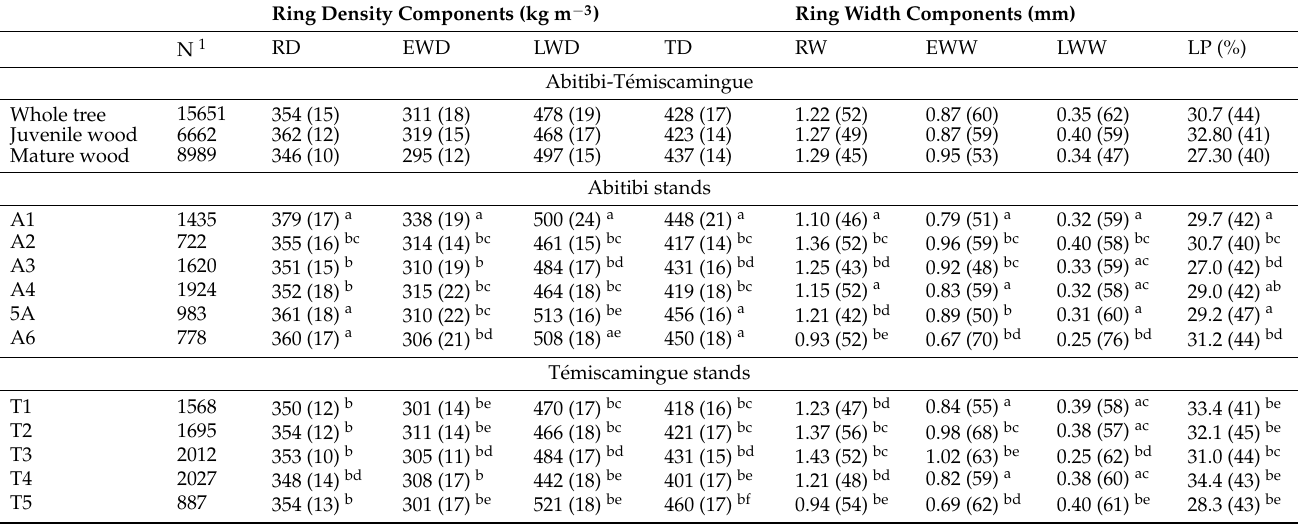
Table 2. Means and coefficients of variation (CV) (in parentheses (%)) of ring widths and ring density components at breast height in Thuja occidentalis in the Qu é bec Boreal Forest and as a function of the